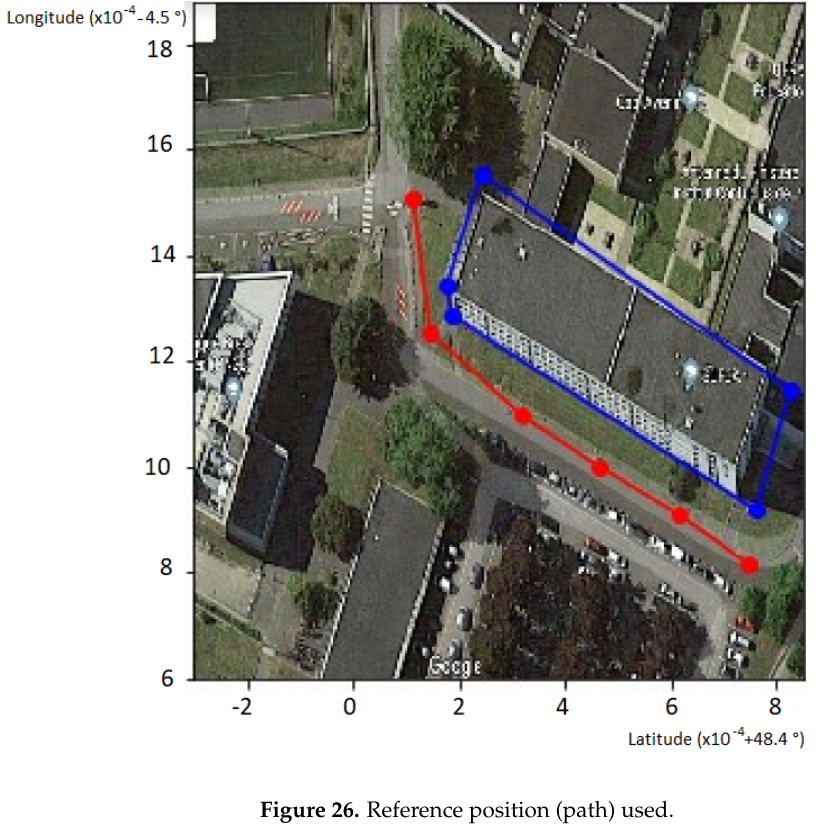
Figure 26. Reference position (path) used.